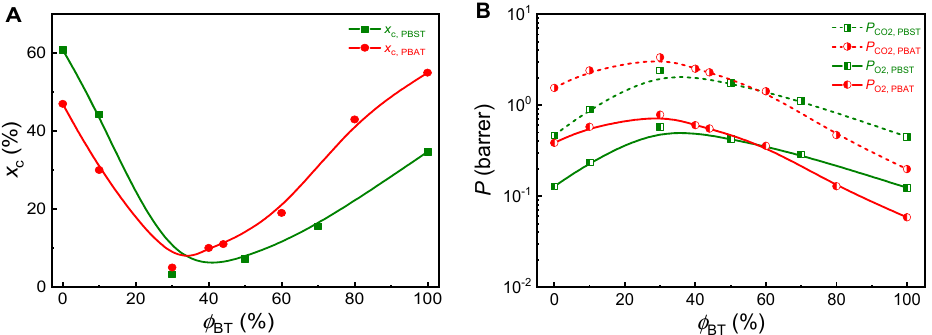
Figure 2. ( A ) Crystallinity ( x c ) of PBAT and PBST copolyesters changes with composition ( ϕ BT = 0– 100 mol%, data from refs. [19,29]) and ( B ) the O 2 and CO 2 permeability coefficients ( P O2 , P CO2 ) of the PBAT and PBST copolyesters predicted from the crystallinity data.